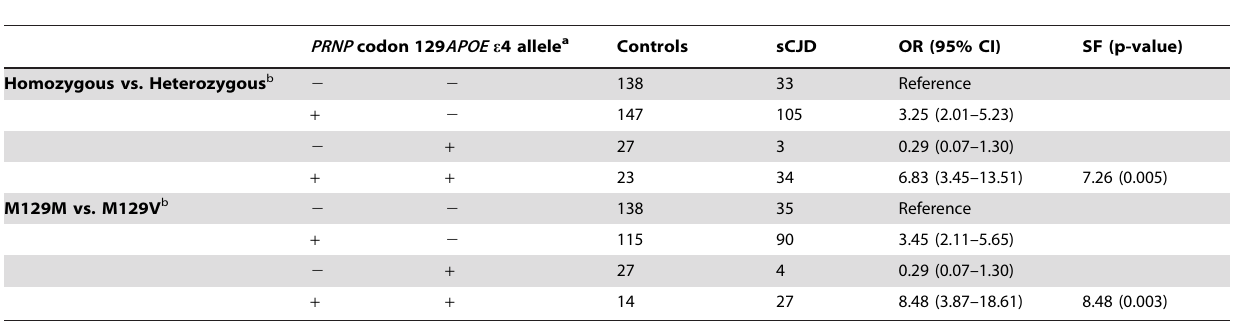
Table 7. Synergy in sCJD population between APOE and PRNP